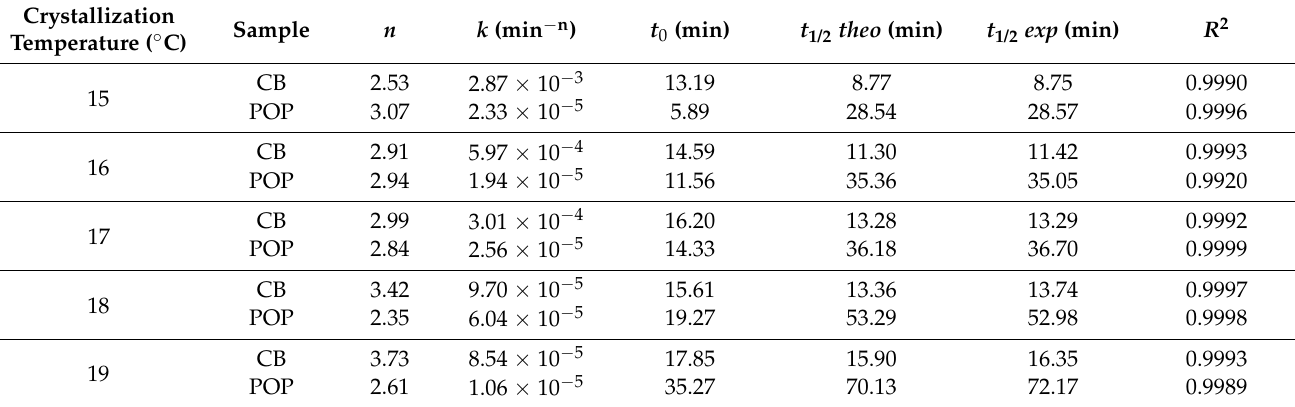
Table 3. Kinetics crystallization of CB and POP standard at different T c